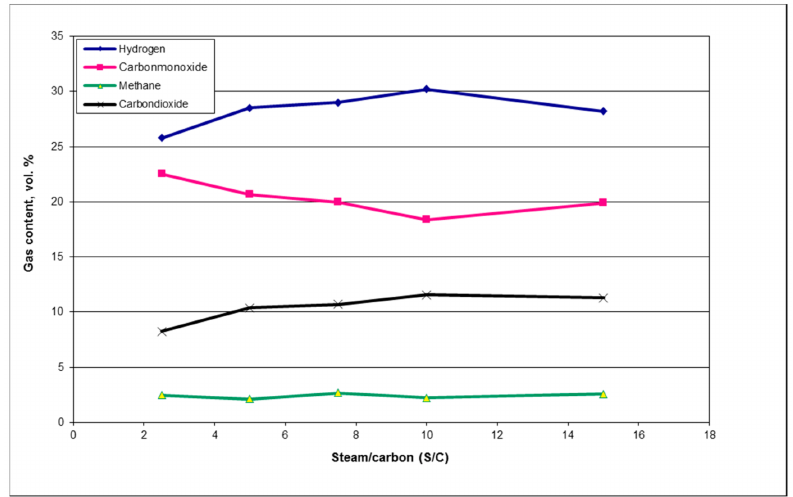
Figure 6. Effect of the S/C ratio on gas composition. Initial gas composition: H 2 (20%), CO (20%), CO 2 (10%), CH 4 (3%) (T—750 ◦ C, GHSV—12,800 h − 1 , catalyst—7.5% Ni-montmorillonite, naphthalene loading—58 g/Nm 3 ).